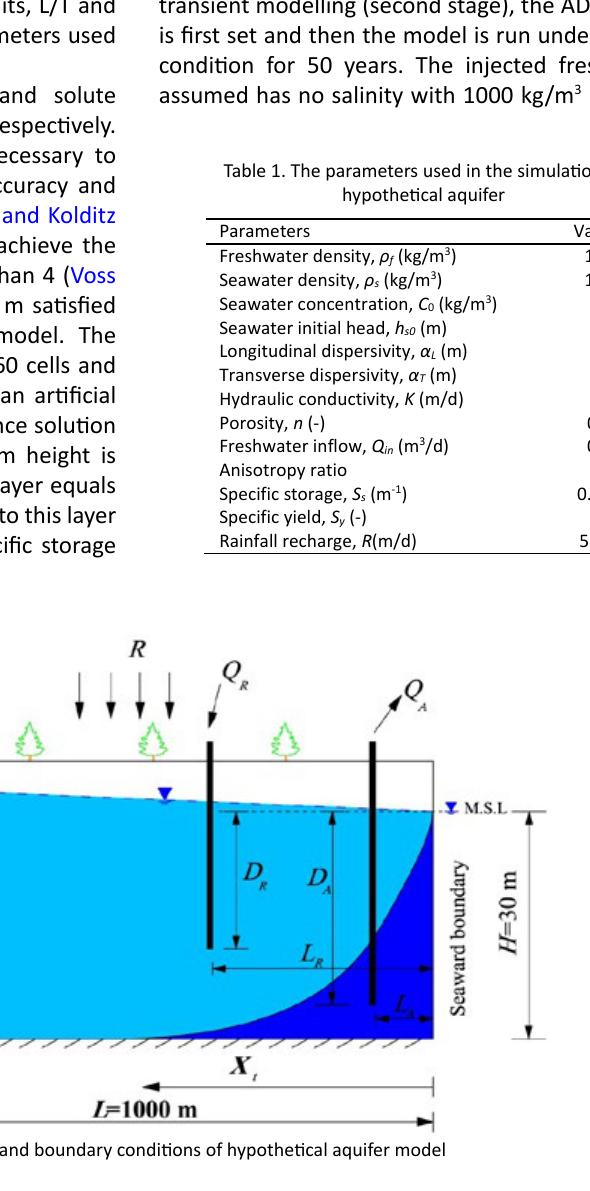
Fig. 1. The geometry and boundary conditions of hypothetical aquifer model